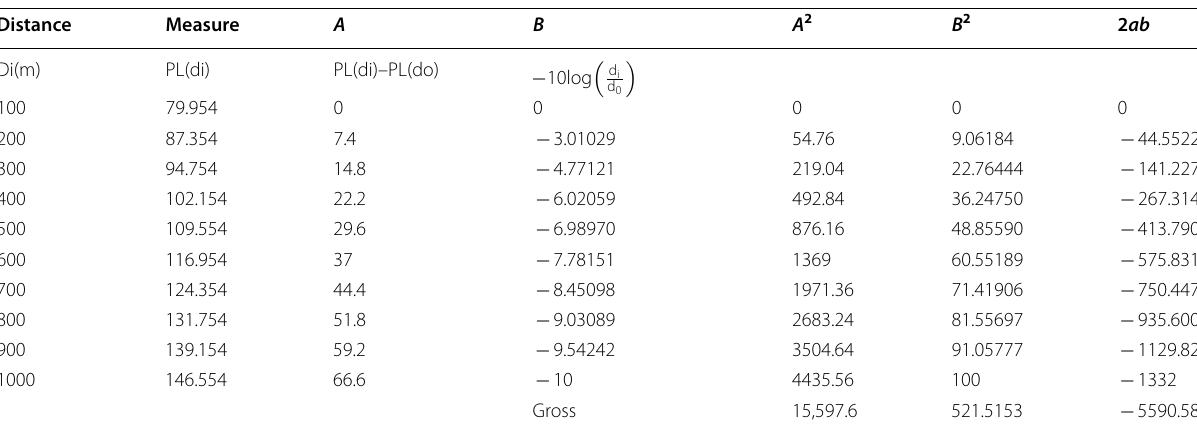
Table 5 Predicted path loss for Dokki